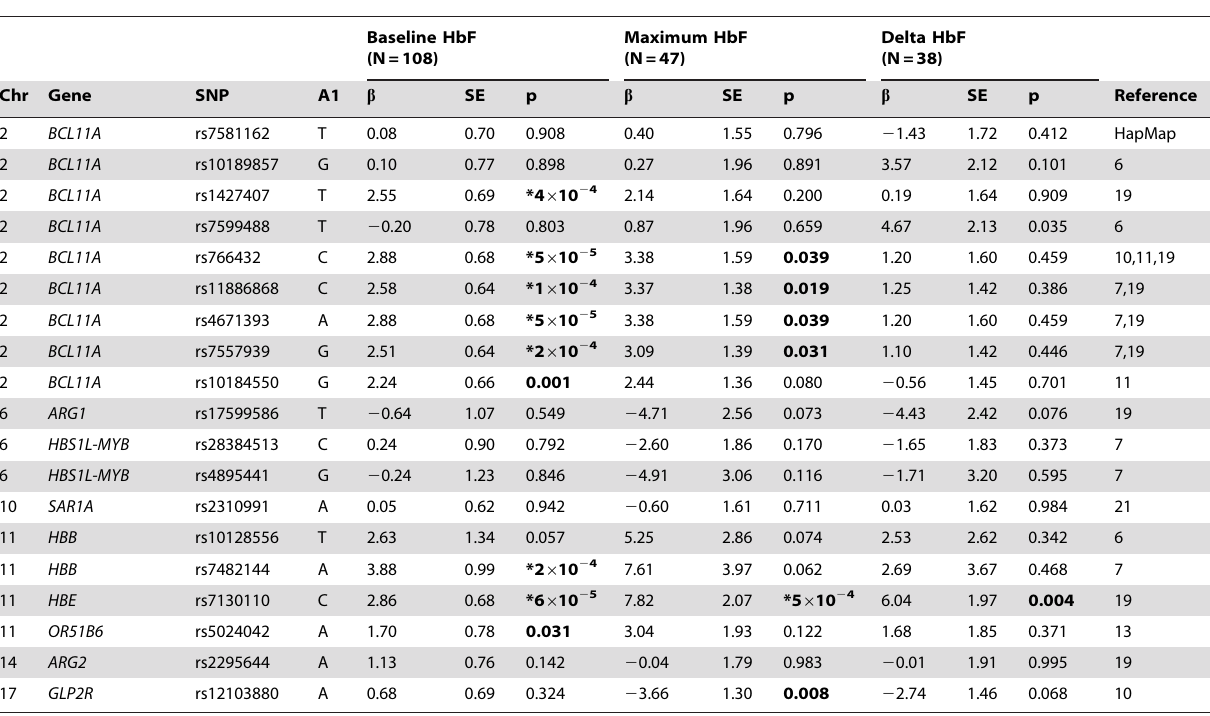
Table 1. 19 SNPs associations with baseline, maximum and delta